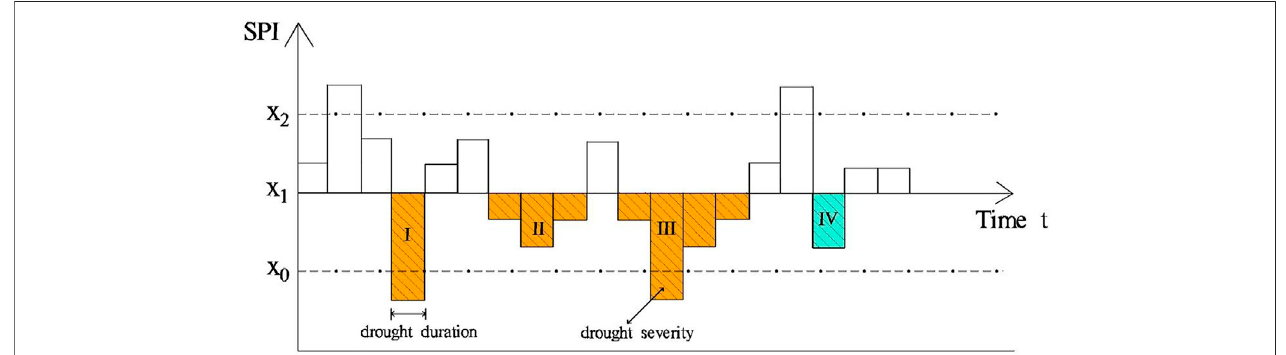
FIGURE 2 | Drought event identi fi cation process by Run